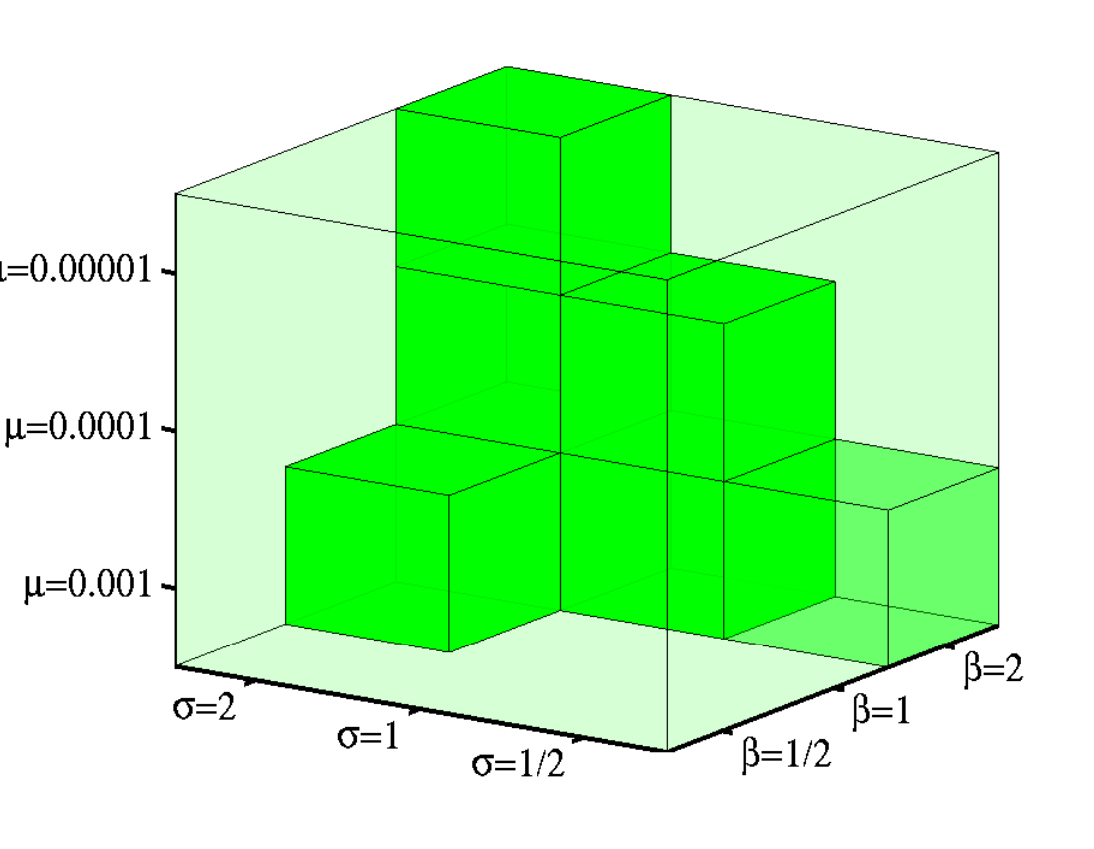
Figure 3. The areas of the 3-dimensional parameter space ( b , s , m ) where complete germ-soma differentiation was observed (filled cubes). a ~ b . For b ~ 2, s ~ 1 = 2 , and m ~ 0 : 001 (lightly colored subcube), the major locus effects X and Y evolved very close to 1 but the modifier effects x and y were around 0 : 4 { 0 : 7 .